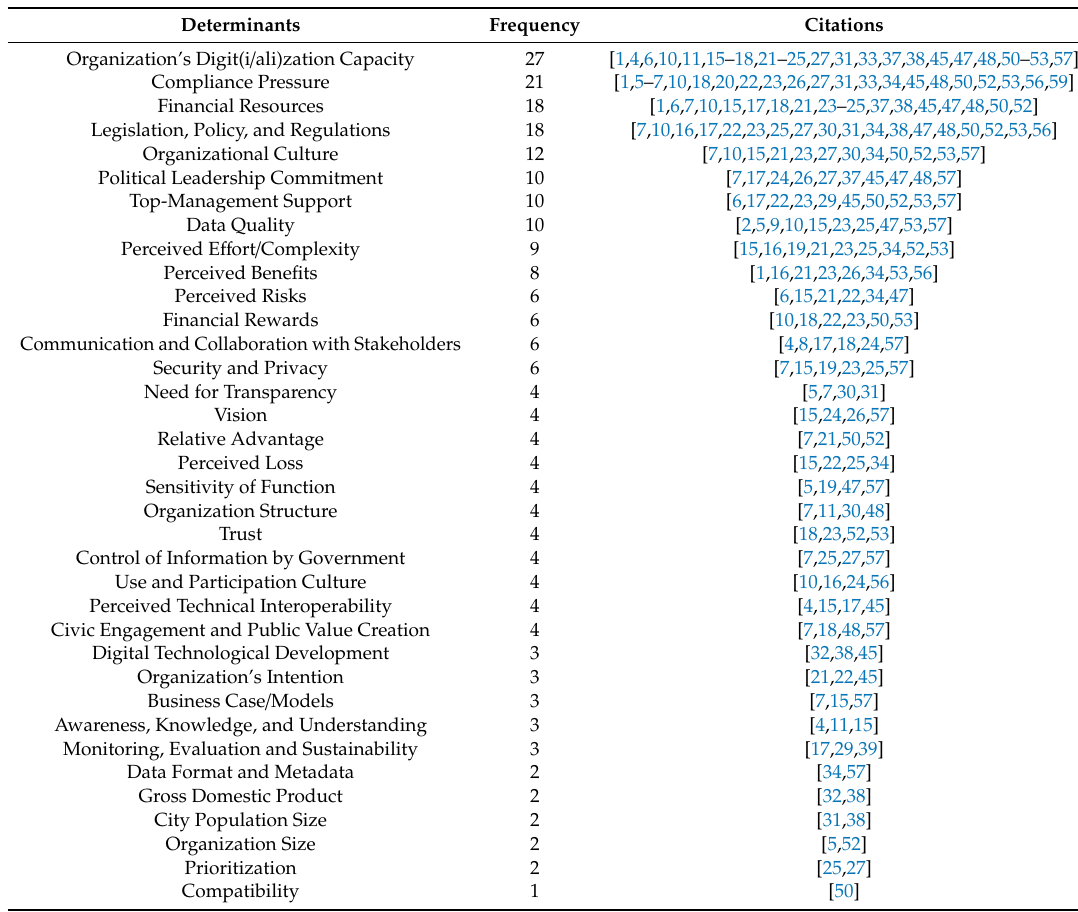
Table 8. Potential Determinants of OGD